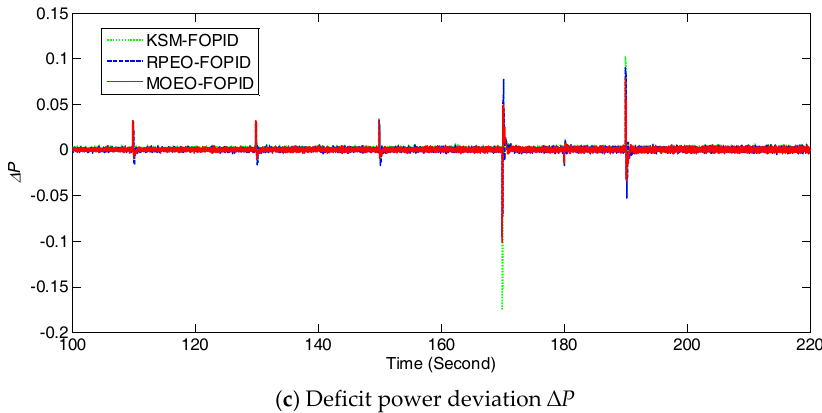
Figure 8. Comparison of frequency deviation ∆ f ( a ), control signal u ( b ) and deficit power deviation ∆ P ( c ) of the test microgrid with FOPID controllers obtained by the MOEO algorithm and single-objective optimization algorithms including KSM and RPEO.